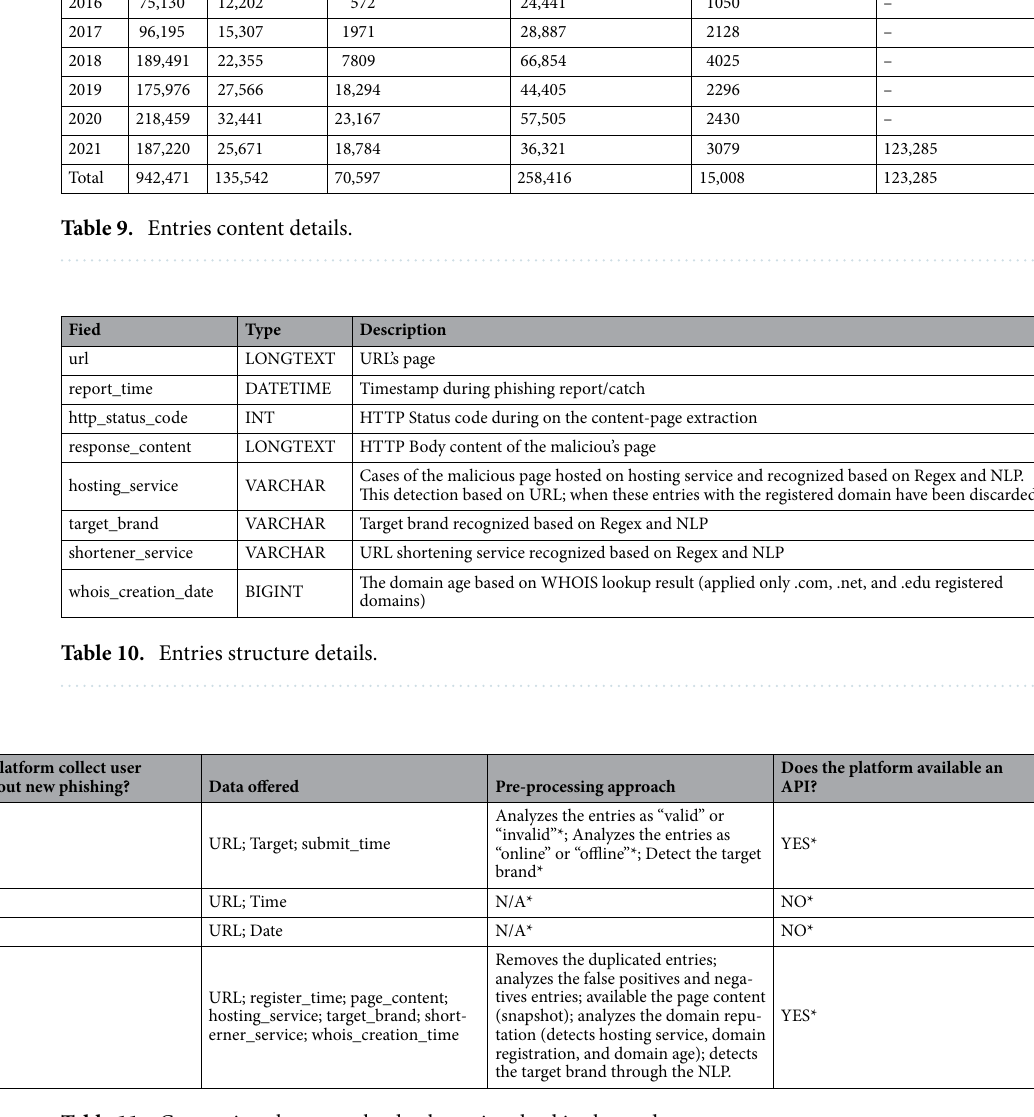
Table 11. Comparison between the databases involved in the